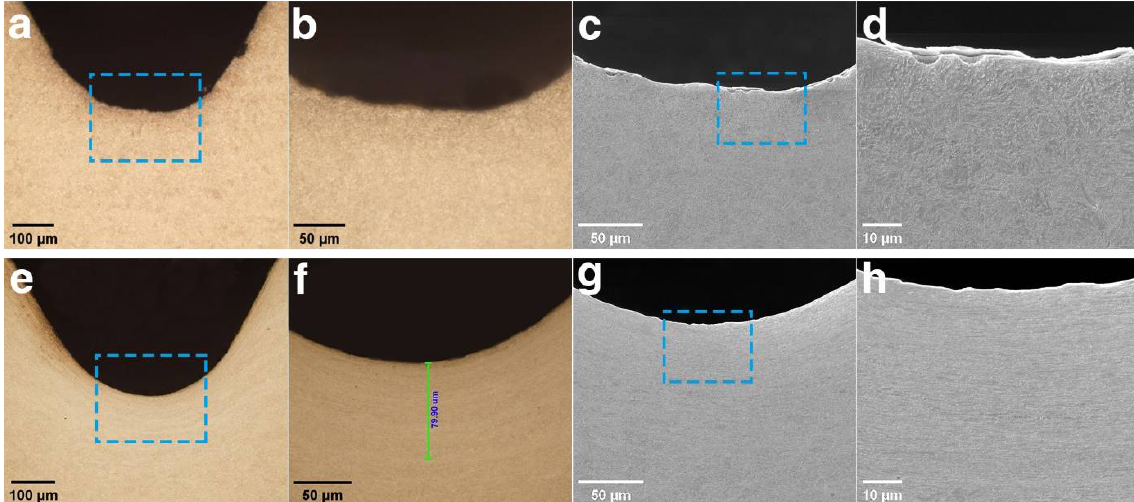
Figure 3. Cross-section metallographic structure of the bottom of the thread. ( a , b ) OM image of the as-received bolt at 200× and 500×. ( c , d ) SEM image of the as-received bolt at 1 k× and 3 k×. ( e , f ) OM image of the rolled bolt at 200× and 500×. ( g , h ) SEM image of the rolled bolt at 1 k× and 3 k×.